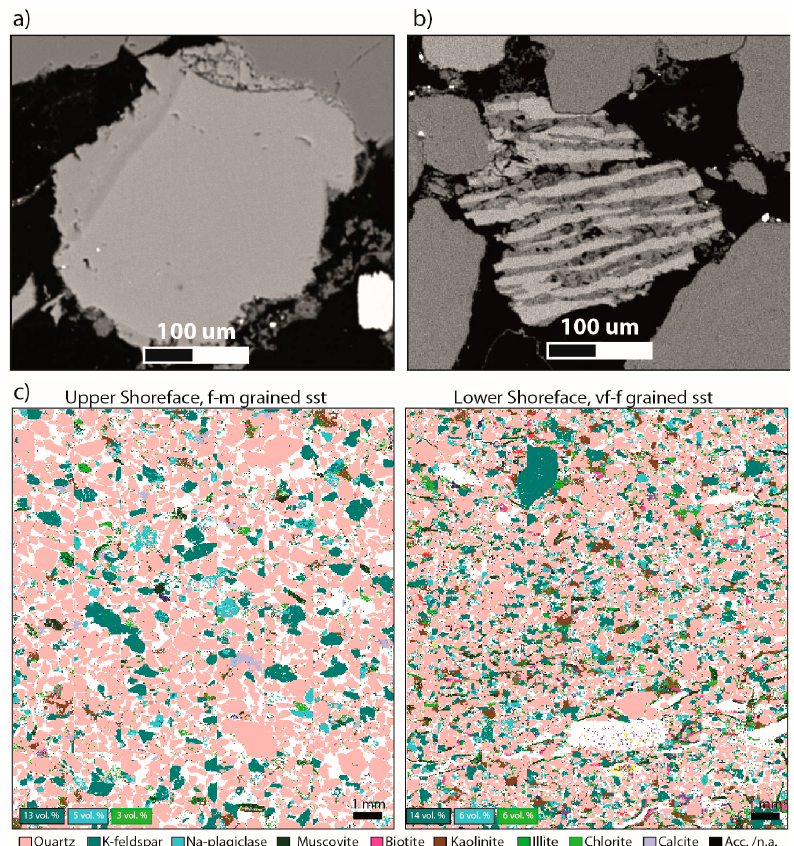
Figure 4. Feldspar occurrences and elemental mapping: ( a ) Scanning electron micrograph of K-feldspar grain with spiky, euhedral overgrowths. Note the compositional change across the outline of the original, detrital grain. The autigenic component is pure microcline, compared to the detrital K-feldspar grain with more heavy elements; ( b ) feldspar perthite grain (scanning electron micrograph). The albite component (dark colour) is partly dissolved, while microcline (light colour) is preserved. This grain is likely to display large mineral surface area compared with average grain sizes; ( c ) mineral maps from Scanning Electron Microscopy (QemScan analysis, Equinor—by C. Kruber), showing the relative volume fractions of the main mineral constituents. Corresponding wt% from XRD (Rietveld) are: 10 wt% K-felspar, 6 wt% Albite, and 2 wt% chlorite in this f-m grained sandstone (2125.4 m), and 12 wt% K-felspar, 5 wt% Albite and 9 wt% chlorite in this very fine grained sandstone (2129.3 m).